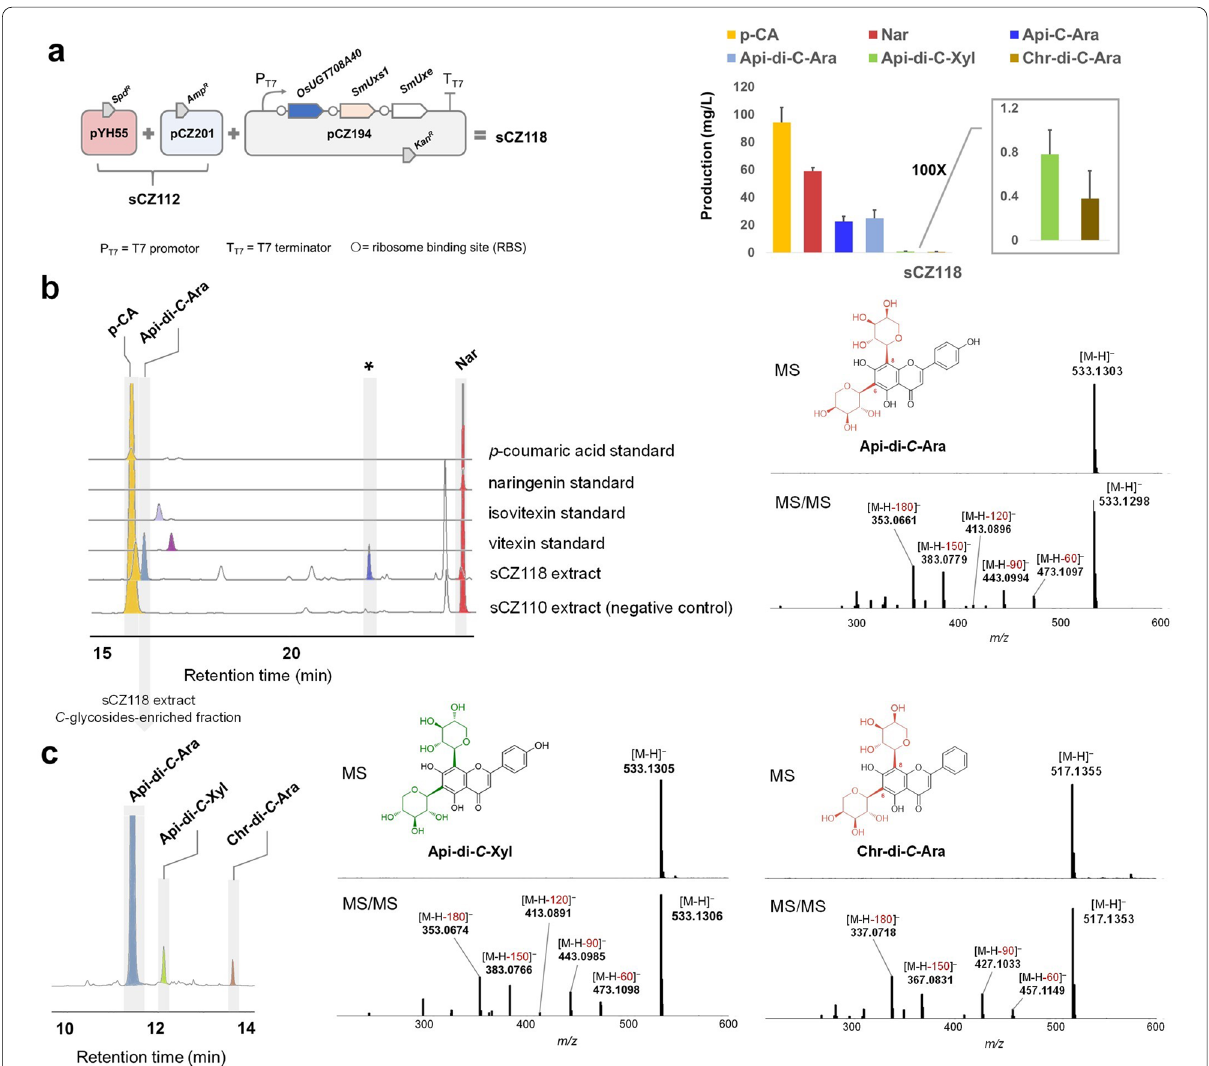
Fig. 4 De novo biosynthesis of uncommon C -glycosides. a pYH55 (Nar module) (Li et al. 2019), pCZ201 (cytochrome P450 module) (Sun et al. 2020) and pCZ194 (arabinosylation module) were co-expressed to reconstitute apigenin di- C -arabinoside (Api-di- C -Ara) pathway in E. coli chases. b HPLC analysis of the extract of sCZ118 and HR-MS fragmentation of Api-di- C -Ara. The peak indicated in asterisk was temporarily identified as apigenin 6(8)- C -arabinoside. UV absorbance at 280 nm was monitored. c Characterization of minor C -glycosides co-eluted with Api-di- C -Ara. HR-MS and MS/ MS indicated the presence of apigenin di- C -xyloside (Api-di- C -Xyl) and chrysin 6,8- C -di-arabinoside (Chr-di- C